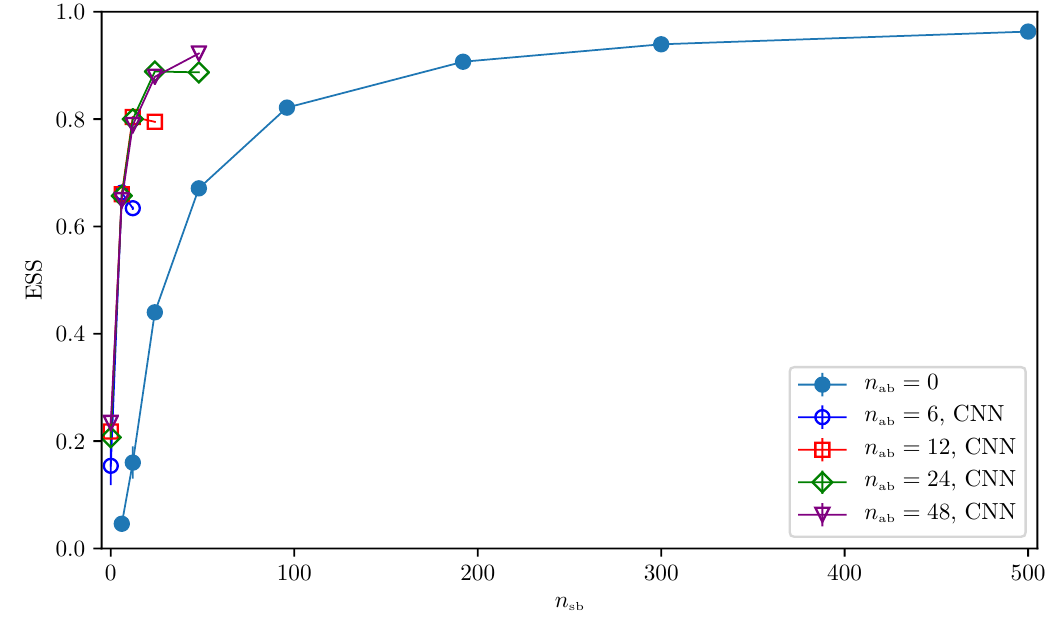
Figure 1 . Effective sample size for different flows, for varying number of affine blocks n ab and stochastic blocks n sb , for 16 × 8 lattices at κ = 0 . 2 , λ = 0 . 022 . The n ab = 0 points are purely stochastic evolutions, where no training is required, while the n sb = 0 data represent standard nor- malizing flows. The remaining points in the plot represent SNFs, where stochastic blocks are placed between affine blocks. Error bars are not visible for most of the flows and stochastic evolutions under consideration due to the very small statistical